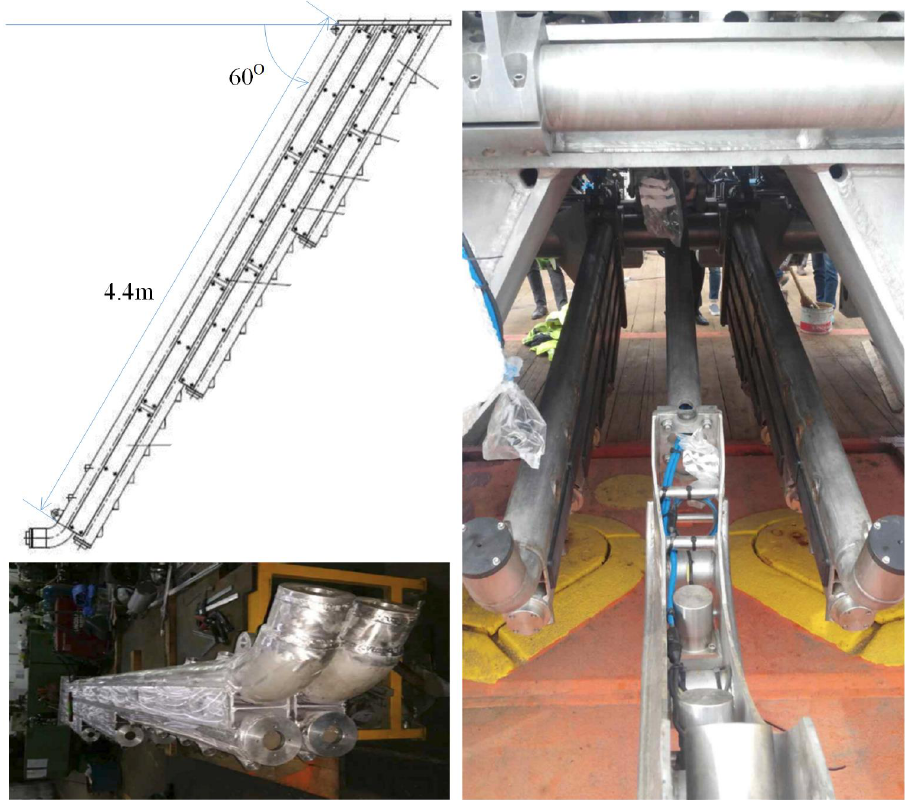
Figure 12. Final prototype design and its installation on the trencher